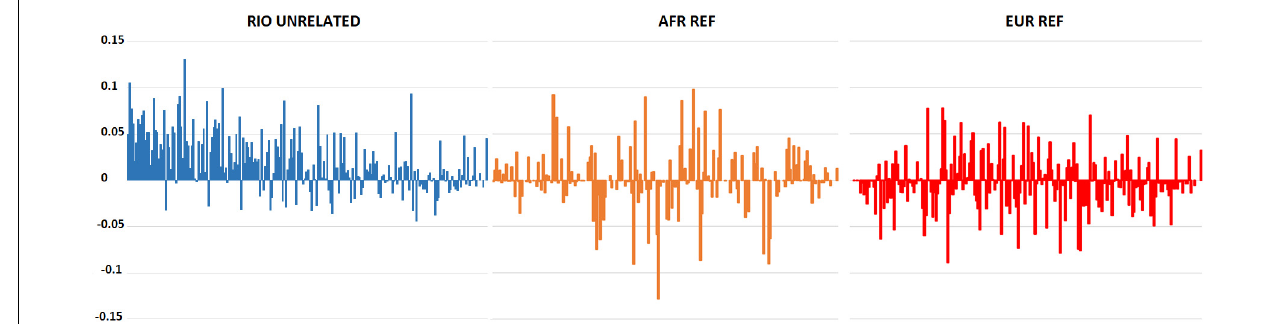
FIGURE 1 | Differences between expected and observed heterozygosity values for the 210 AIMs in the Rio de Janeiro, AFR, and EUR reference samples. A positive value reflects an excess of homozygotes for the marker. Markers are presented in descending order of absolute allele frequency differences between AFR and EUR (more information on Supplementary Table S2 ).